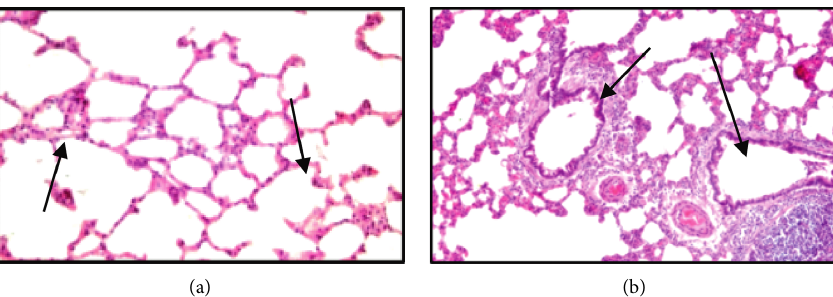
Figure 4: Histological structure of the lungs of intact rats: (a, b) staining with hematoxylin and eosin. (a) Emphysematous enlargement of the alveoli; uneven moderately expressed thickening of the interalveolar septa against the background of vascular congestion and edema, zoom x100. (b) Lymphocytic infiltrates in the interalveolar septa, around the congested vessels and bronchi; bronchi with preserved contours and moderate secretory activity of the epithelium, zoom x160.